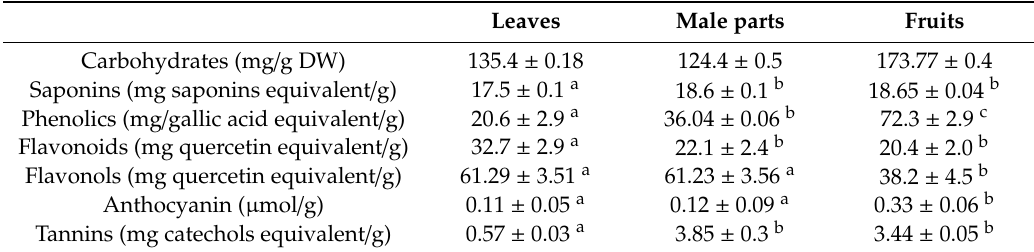
Table 1. Phytochemical analysis of H. thebaica leaves, male parts and fruits. Leaves Male parts Fruits Carbohydrates (mg / g